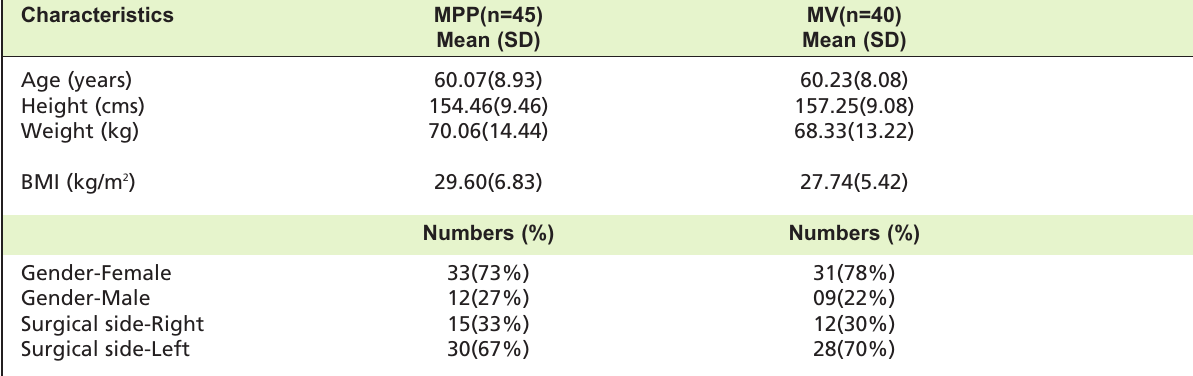
Baseline Demographics and Clinical Characteristics of both groups Table I: